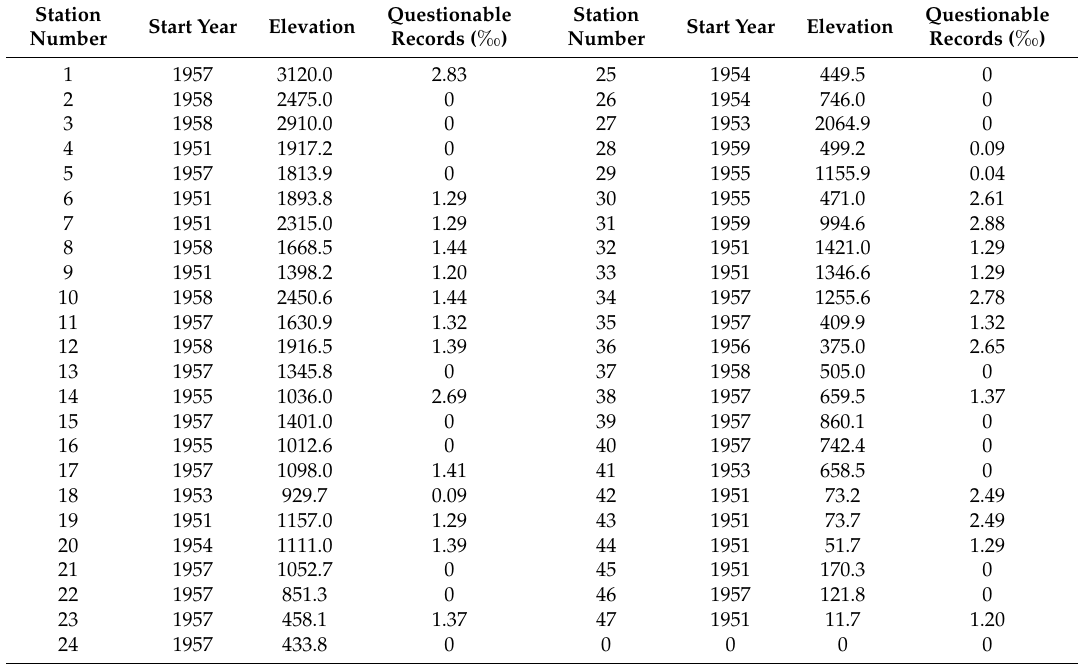
Table 1. Summary of meteorological stations used in this study, including start years of records, elevations of stations and proportions of questionable